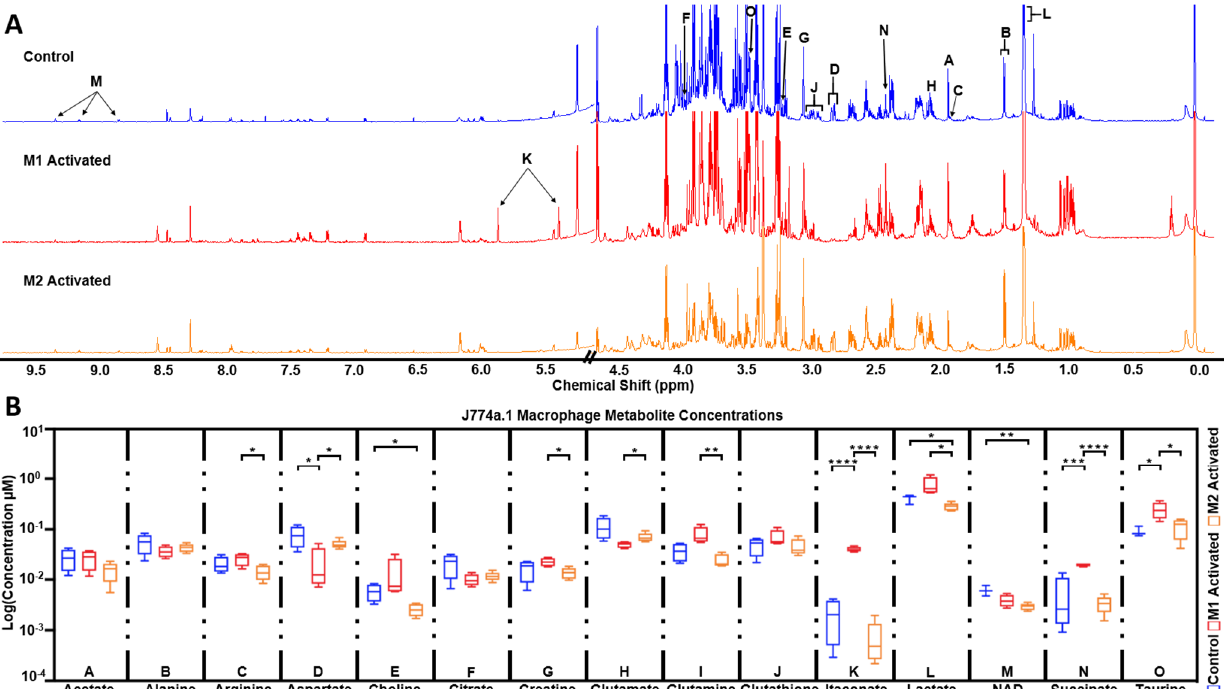
Figure 5. High resolution 1 H NMR detects significant differences in extracted metabolites between control, M1, and M2 macrophages. ( A ) Representative high resolution 1 H NMR 1D NOESY spectra of control (blue), M1-activated (red), and M2-activated (orange) J774a.1 macrophage extracts (water region omitted; normalized to cell number with axes scaled identically). ( B ) Metabolite concentrations between control (blue; N = 4), M1-activated (red; N = 5), and M2-activated (orange; N = 5) determined from 1 H NMR data. Data reported in log for purpose of presentation, with statistics performed on metabolite concentration (µM) normalized to cell number and TSP. Significance from two-way ANOVA shown between relevant groups with * p < 0.05, ** p < 0.01, *** p < 0.001, **** p < 0.0001.